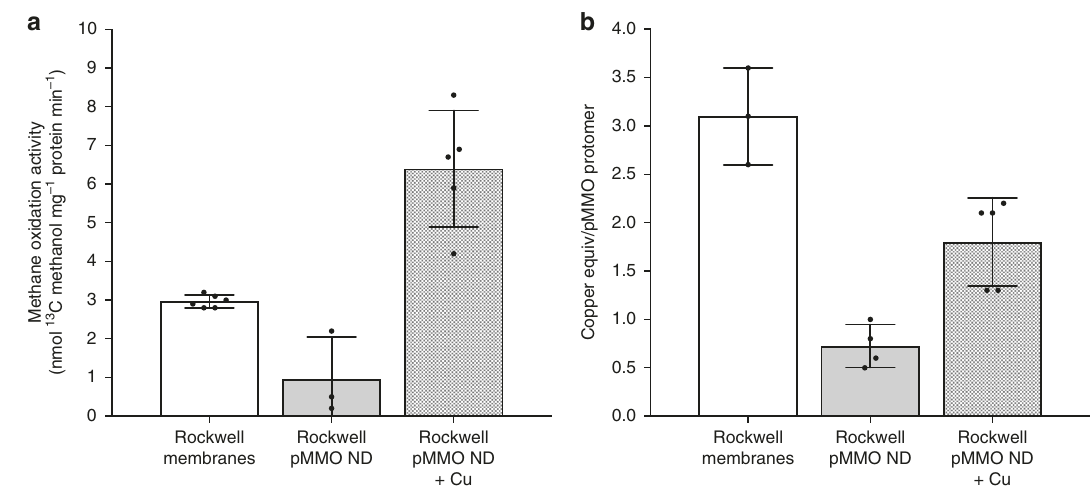
Fig. 7 Activity and metal content of Rockwell-pMMO in nanodiscs. a 13 C methane oxidation activity of Rockwell-pMMO in membranes and in nanodiscs (ND) without or with copper supplementation. Values are shown in nmol 13 C methanol (cid:129) mg − 1 protein (cid:129) min − 1 . Error bars represent standard deviation of individual measurements (black dots) of n = 6, 3, and 5, respectively. b Copper equivalents per pMMO protomer for Rockwell-pMMO in membranes and in nanodiscs without or with copper supplementation. Error bars represent standard deviation of individual measurements (black dots) of n = 3, 4, and 5, respectively. Source data are provided as a Source Data fi